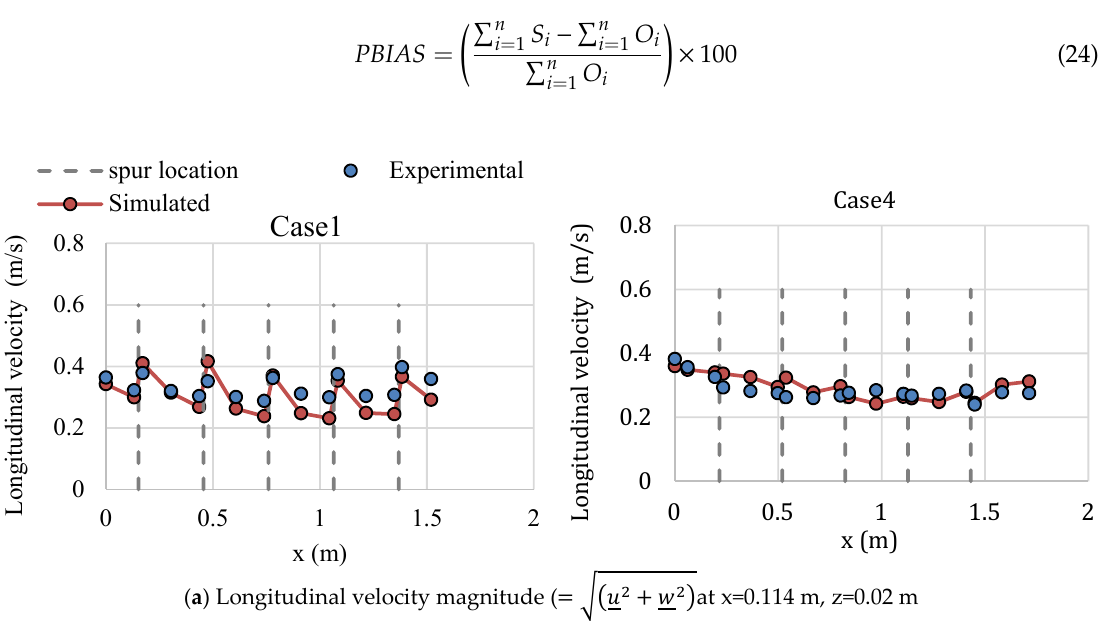
Figure 5. Comparison of experimental and simulated surface velocities for case 1.